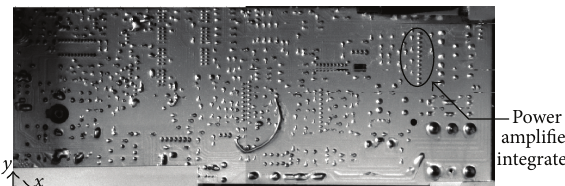
Figure 10: The coated backside PWB (the black ellipse indicates the power amplifier integrated).